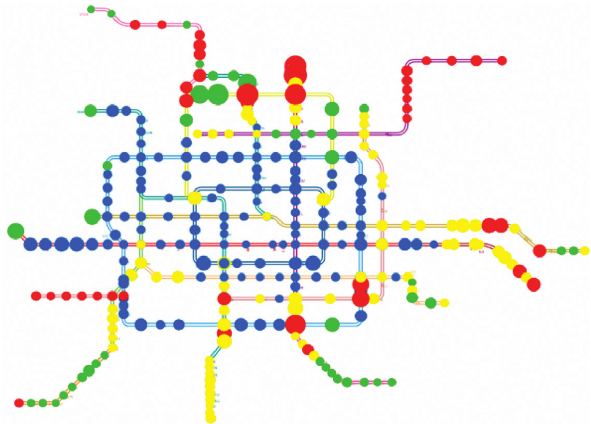
Figure 12: Distribution of various cluster